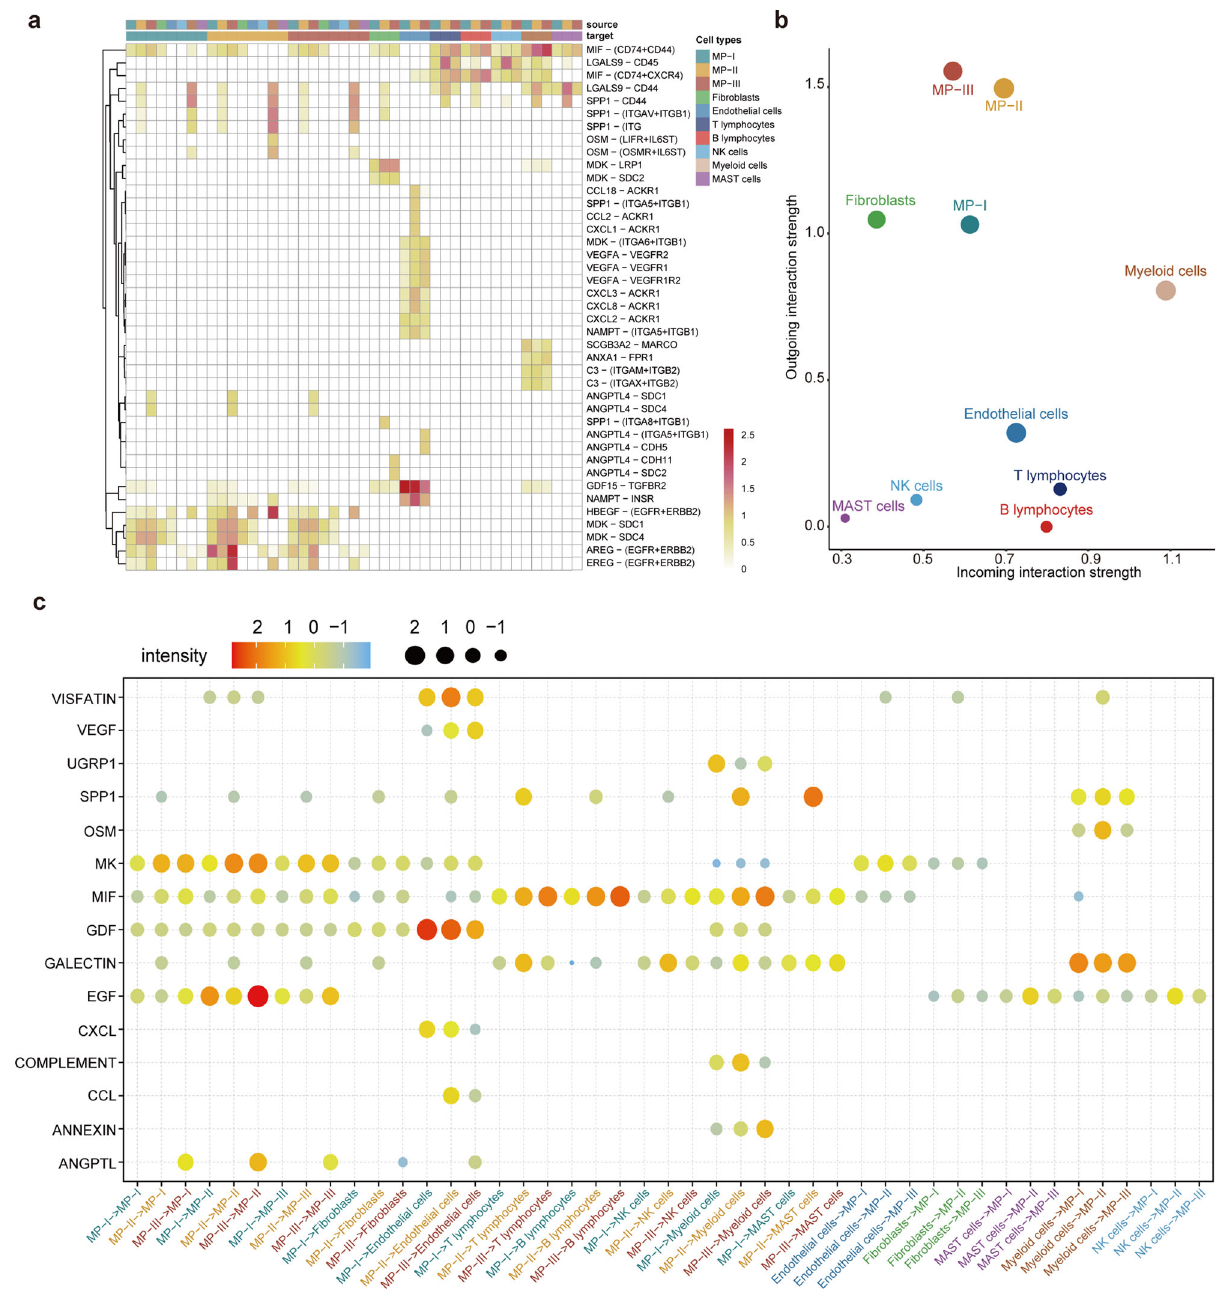
Fig. 6 Identi fi cation of ligand-receptor pairs across 10 cell populations. a Crosstalk intensity heatmap for signi fi cant ligand – receptor pairs across ten cell populations. b Dot plot showing the outgoing and incoming signaling patterns of intercellular communications for ten cell populations. c Crosstalk intensity heatmap for corresponding signaling pathways of ligand – receptor pairs in each cell